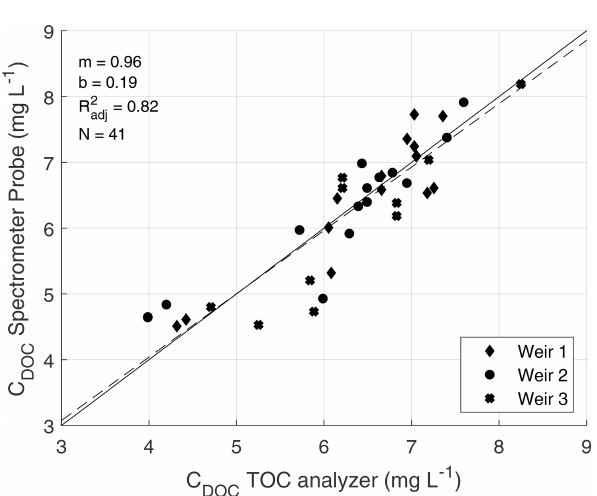
Figure A3. Validation set of C DOC from the TOC analyzer and the spectrometer probe with the corresponding linear regression (dashed line). The solid line represents the 1 : 1 line.